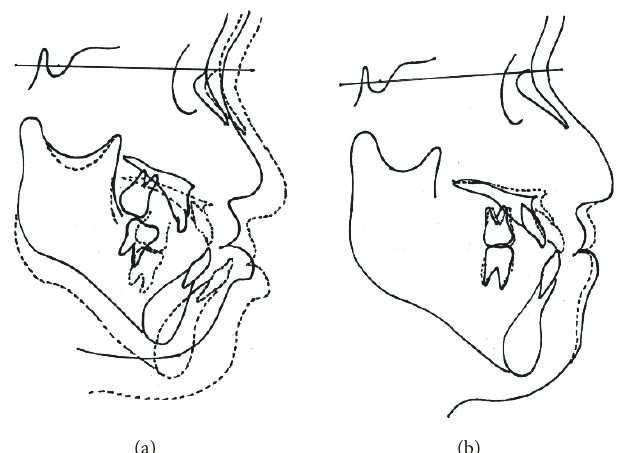
Figure 9: (a) Superimposed cephalometric tracing at pretreatment (solid line) and posttreatment (dotted line) of facemask therapy. (b) Superimposed cephalometric tracing at pretreatment (solid line) and posttreatment (dotted line) of